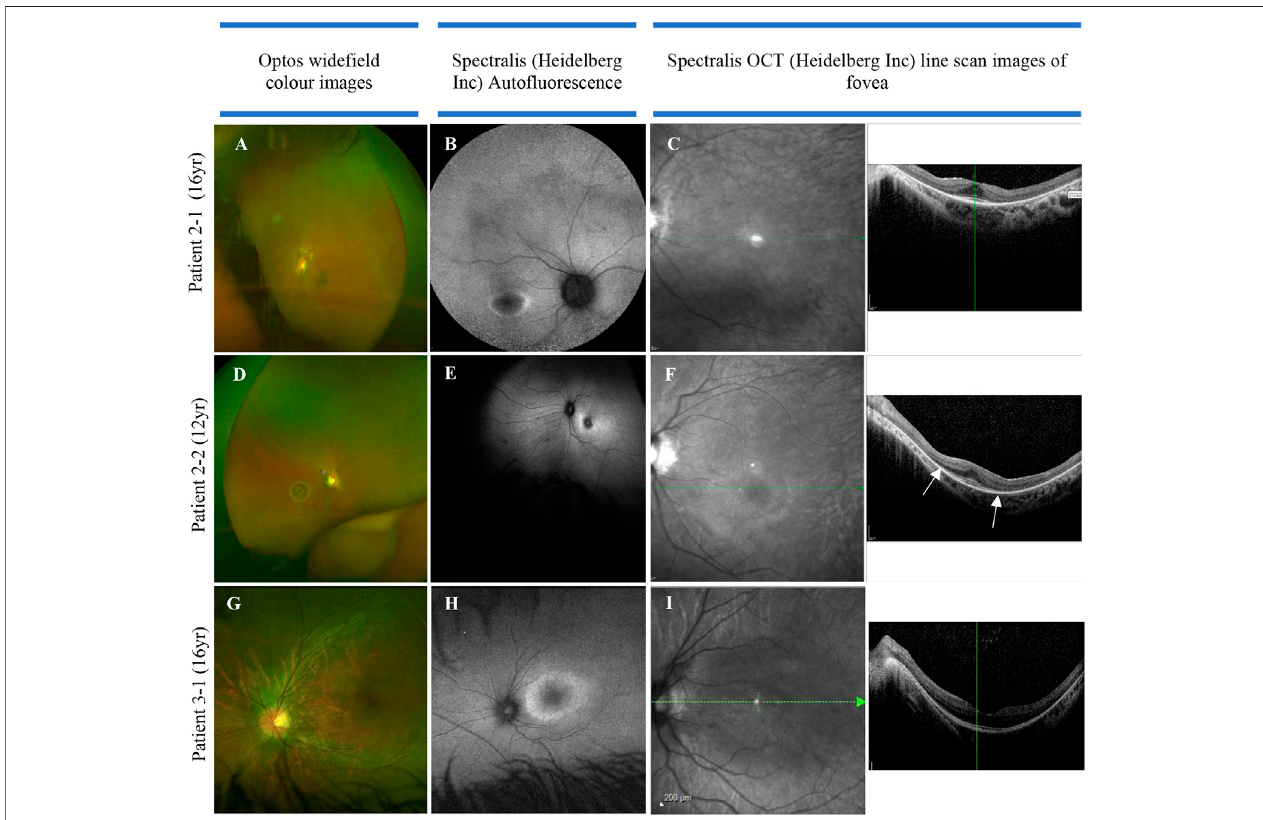
FIGURE 3 | Color fundus, auto fl uorescence, infrared, and OCT images in three individuals of two families with SRD5A3-CDG. (A) Optos image of eye with nystagmus(leadingtosomedistortionoftheimage),demonstratingmildvascularattenuation,myopicovaldiscmorphology,andsubtlemaculare fl exabnormalities.The peripheral retina does not reveal any pigmentary abnormalities; (B) delineating “ watershed ” zone between relatively preserved central retina, and dystrophic periphery; (C) loss ofellipsoid outside theperifoveal region in both eyes; (D) myopic discs, retinal nerve fi ber layer re fl exes constrained to macula, subtle vascular attenuation, and no signi fi cant retinal pigmentation migration suggestive of retinal dystrophy. (E) Abnormal macula with hyper-auto fl uorescent ring around fovea; (F) loss of ellipsoid — the outer retinal layers beyond the fovea (as highlighted by arrows). (G) Color image of left eye; (H) hyper-auto fl uorescent ring illustrating watershed area between preserved central macula function and dystrophic retinal periphery; (I) loss of ellipsoid layer outside the perifoveal retina.